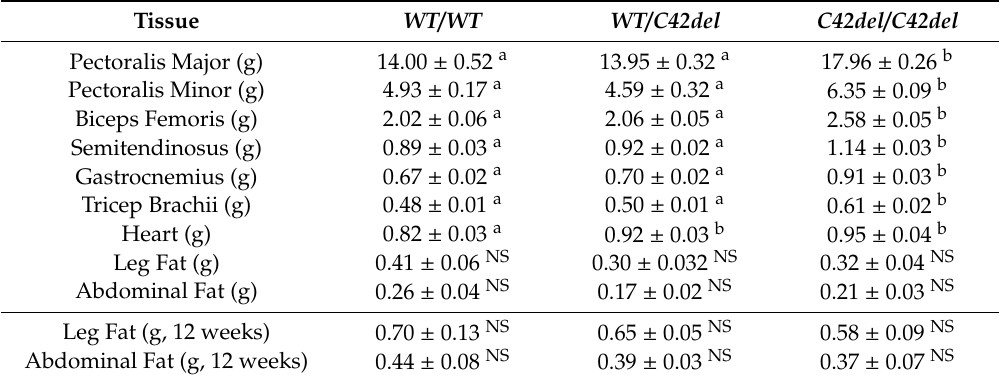
Table 2. Comparison of muscle, adipose tissue, and heart weights in 8- and 12-week old male quail.